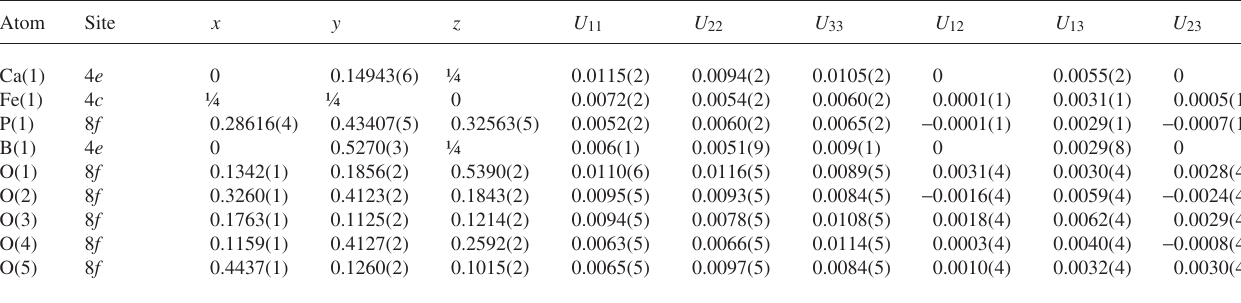
Table 3. Atomic coordinates and displacement parameters (in Å 2 )